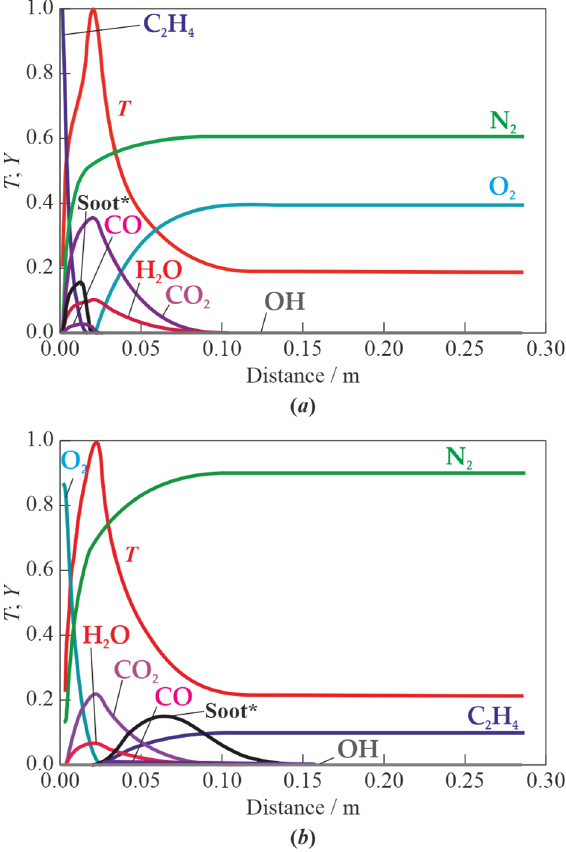
Figure 7. Typical calculated structures of normal ( a ) and inverse ( b ) diffusion flames in 20 s after ignition. Soot mass fractions are increased by a factor of 10 4 ( a ) and 10 6 ( b ).